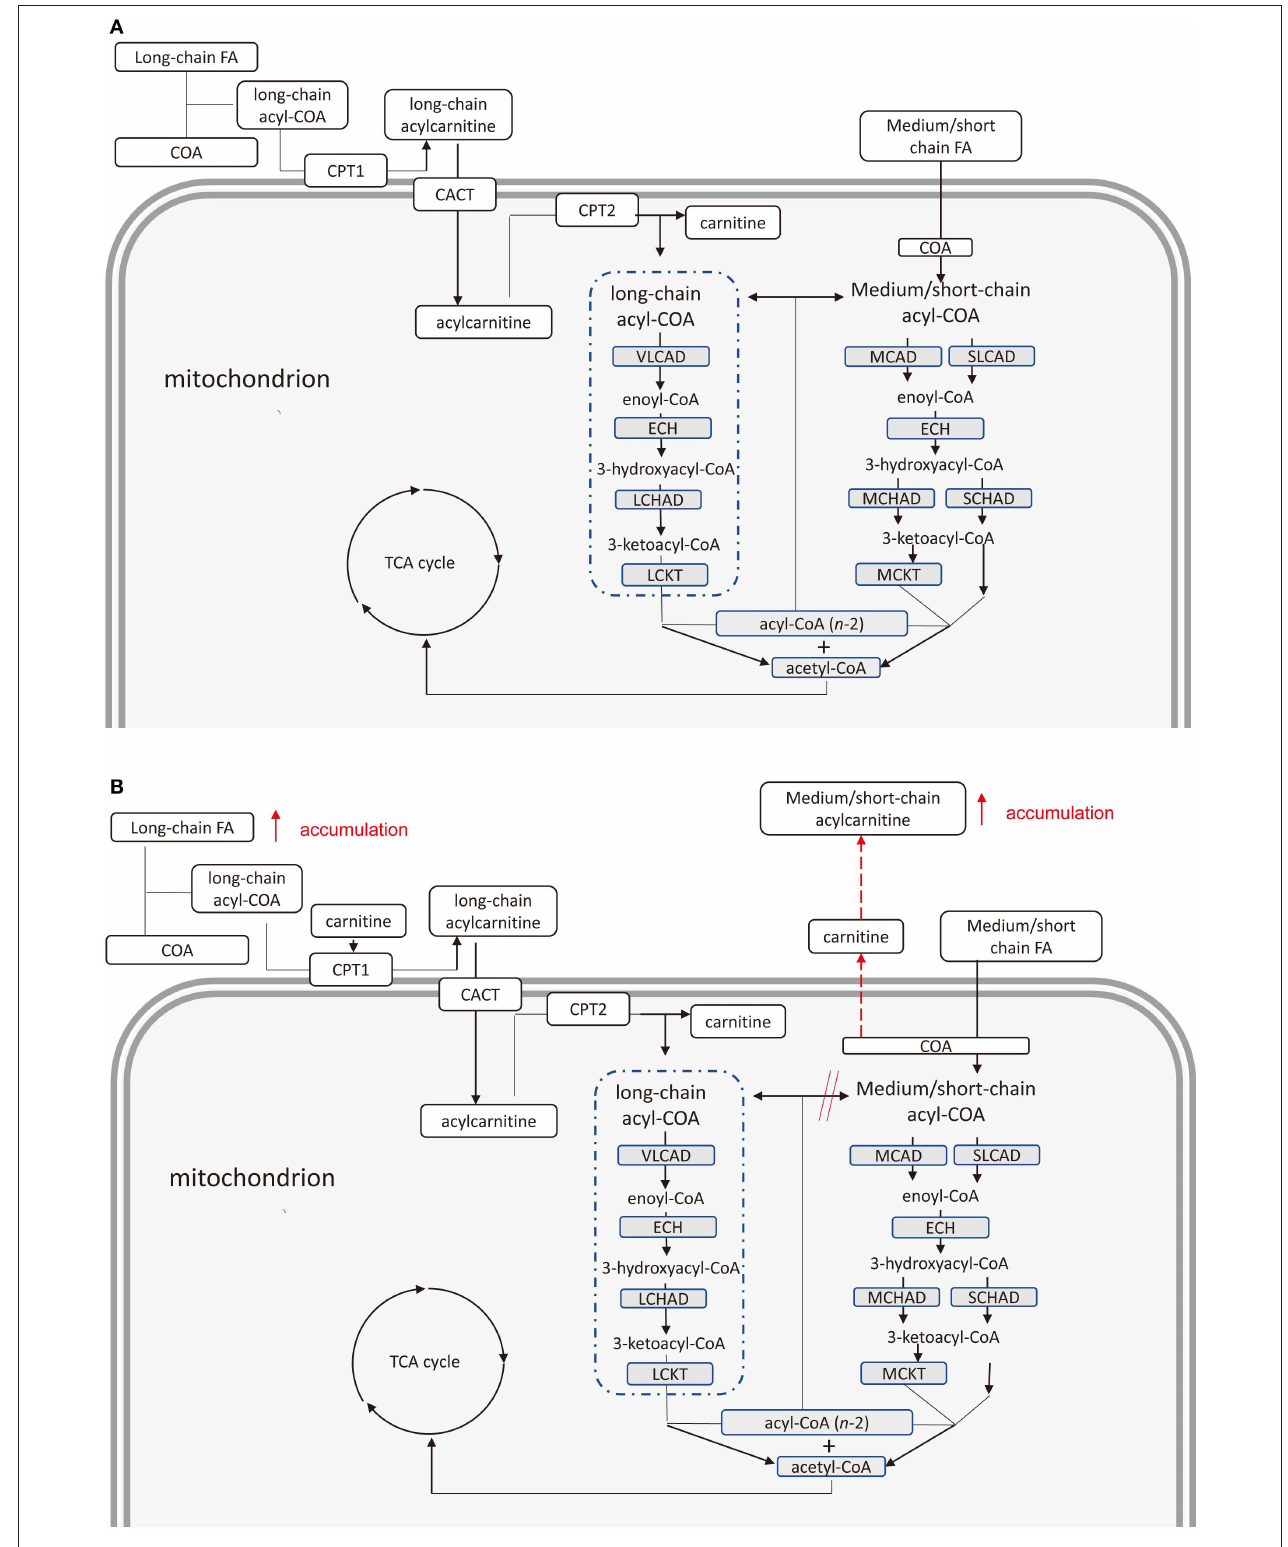
FIGURE 2 | (A) Pathway of fatty acids provide energy in health cardiomyocytes. Chain fatty acids provide energy through the production of acetyl coenzyme A under the combined catalysis of several enzymes. (B) Pathway of fatty acids provide energy in cardiomyocytes of type 2 diabetes mellitus patients with cardiovascular